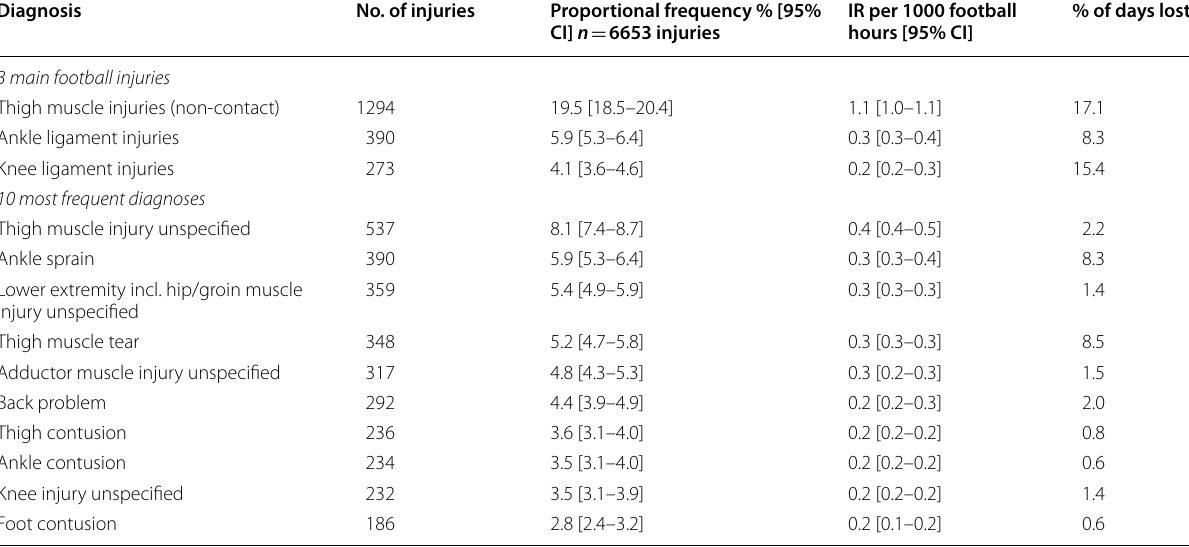
Table 4 Absolute numbers, proportions, IRs, proportions on overall time loss of the “Big 3” injuries and the “Top 10”